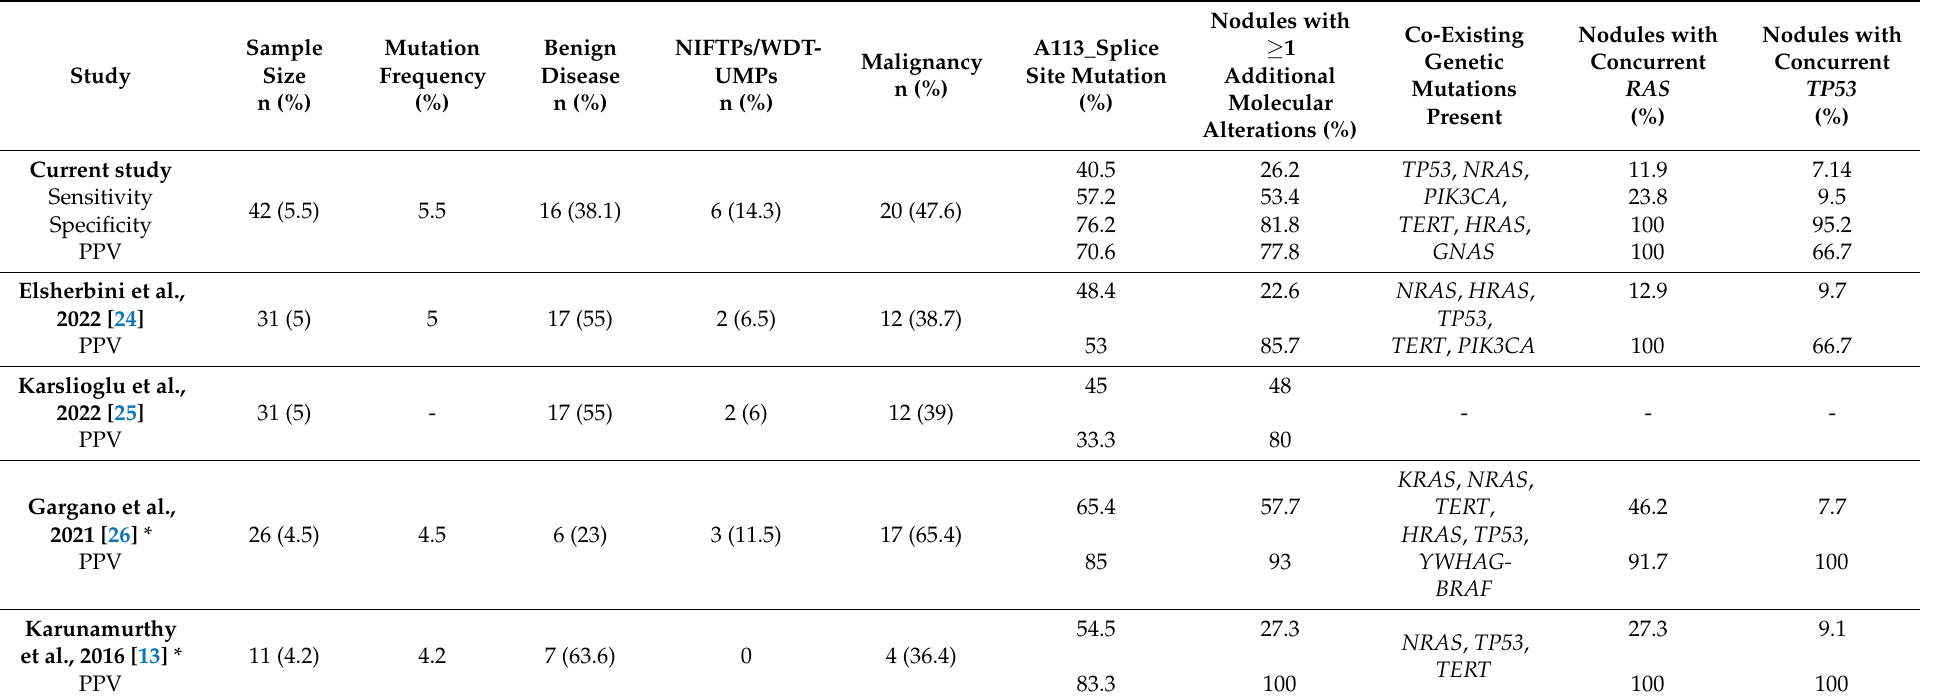
Table 3. Comparison of key results in present and previously published